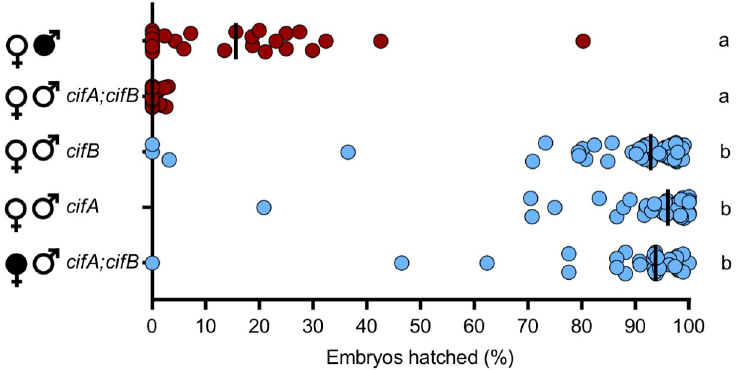
Fig 5. Neither cifA wMel or cifB wMel alone can induce CI when expressed under nos -GAL4:VP16. cifA wMel and cifB wMel were tested for their ability to induce CI individually under nos-GAL4:VP16 expression in uninfected males (open circles). Filled sex symbols represent infection with w Mel Wolbachia and gene names to the right of a symbol represent expression of those genes in the corresponding sex of that cross. Vertical bars represent medians. Letters to the right indicate significant differences with an α = 0.05 calculated by a Kruskal-Wallis analysis followed by Dunn’s multiple comparison